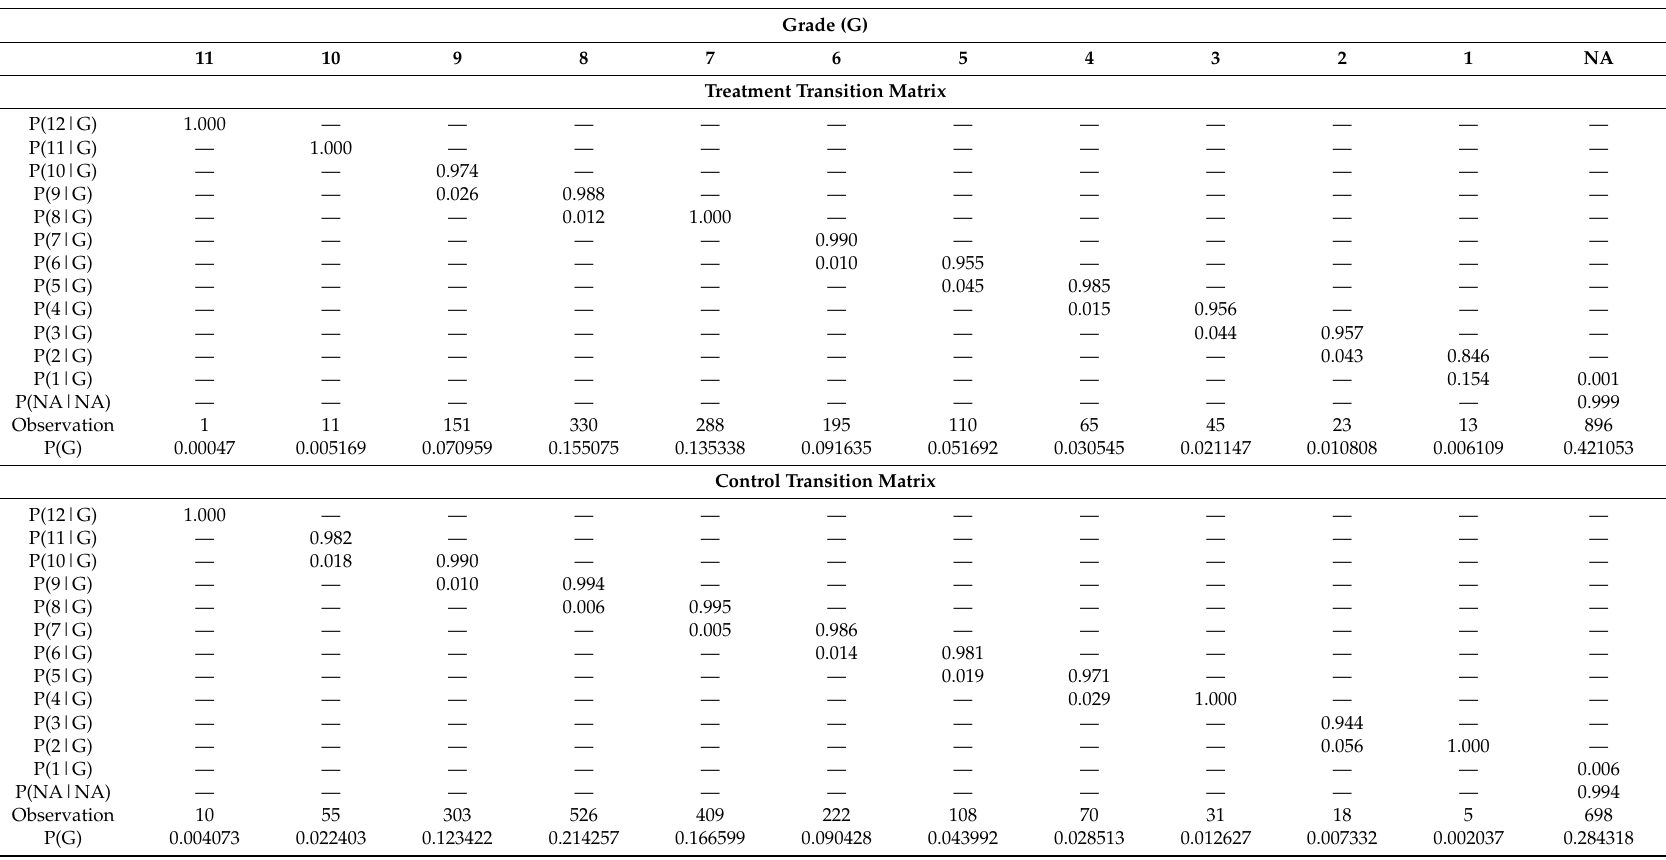
Table A7. Transition matrices (ages